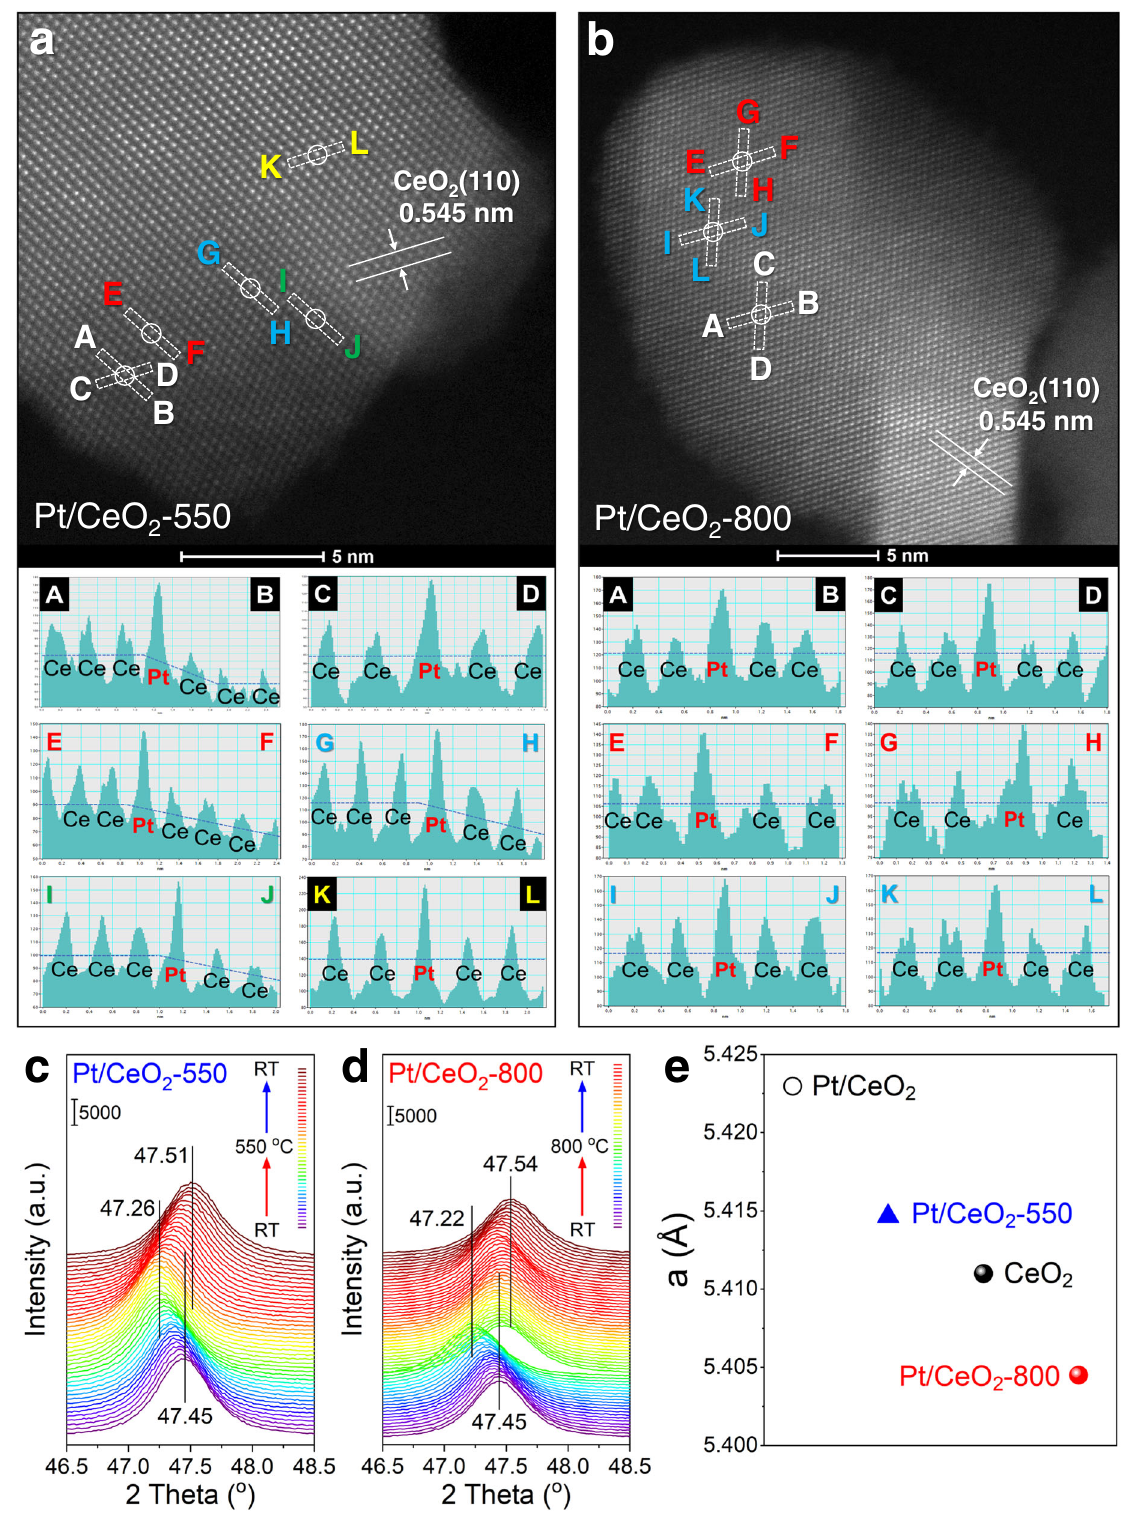
Fig.3|LocationofPtsingleatomsonCeO 2 . AC-HAADF-STEMimagesandtheline pro fi les of a Pt/CeO 2 -550 and b Pt/CeO 2 -800 (additional line pro fi les of Pt/CeO 2 - 800 can be found in Supplementary Fig. 4). In situ XRD patterns for c Pt/CeO 2